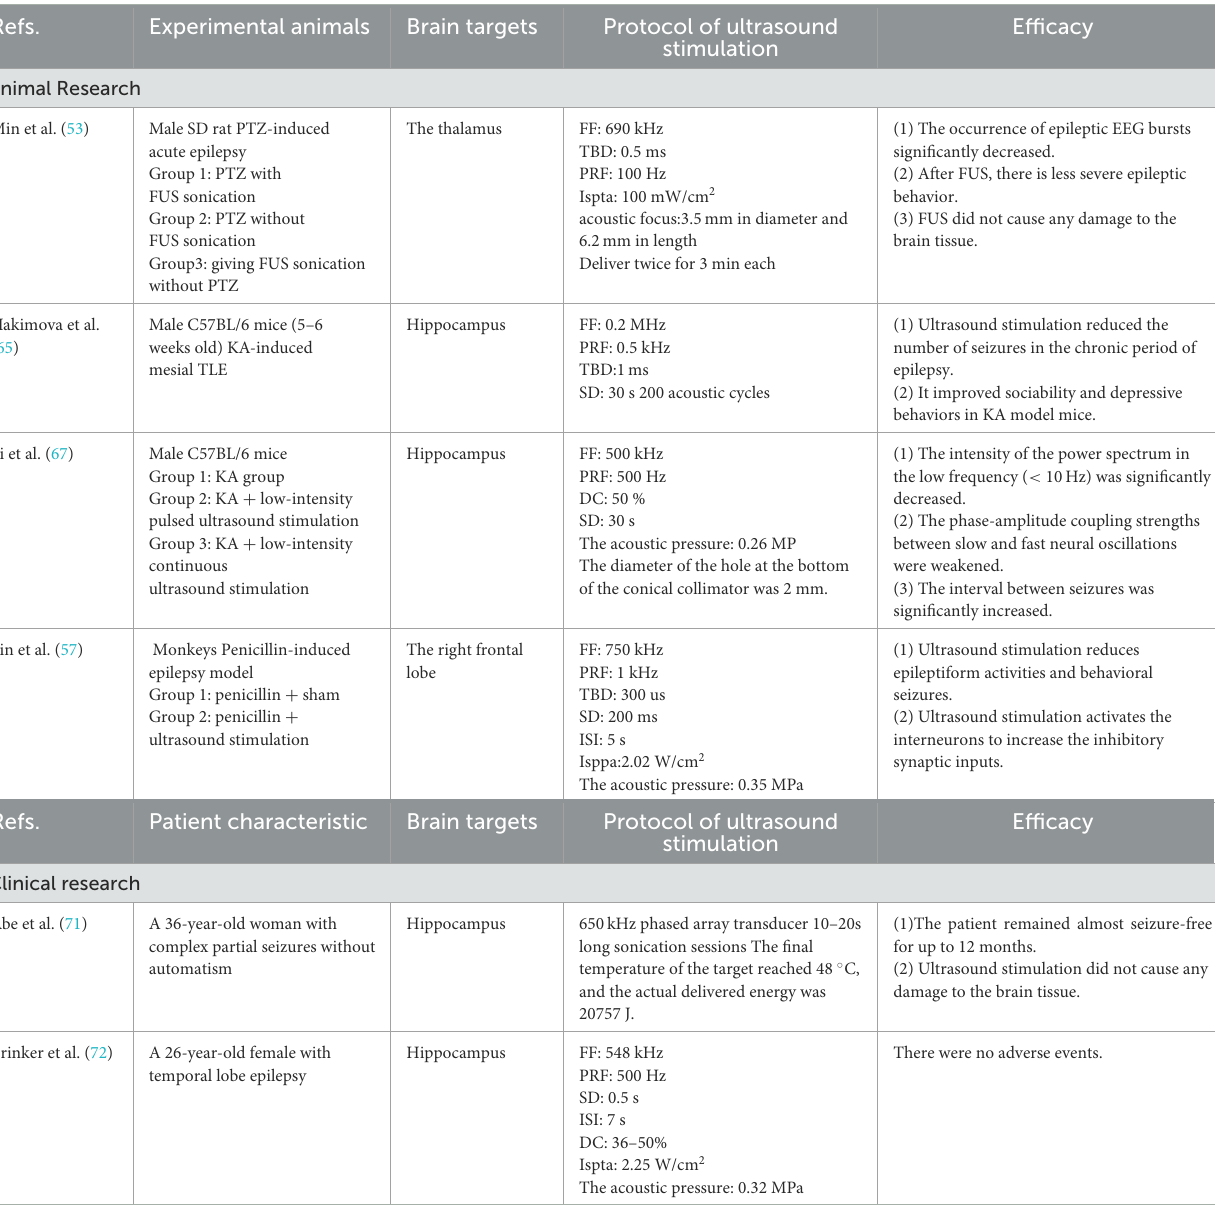
TABLE 1 Ultrasound stimulation in